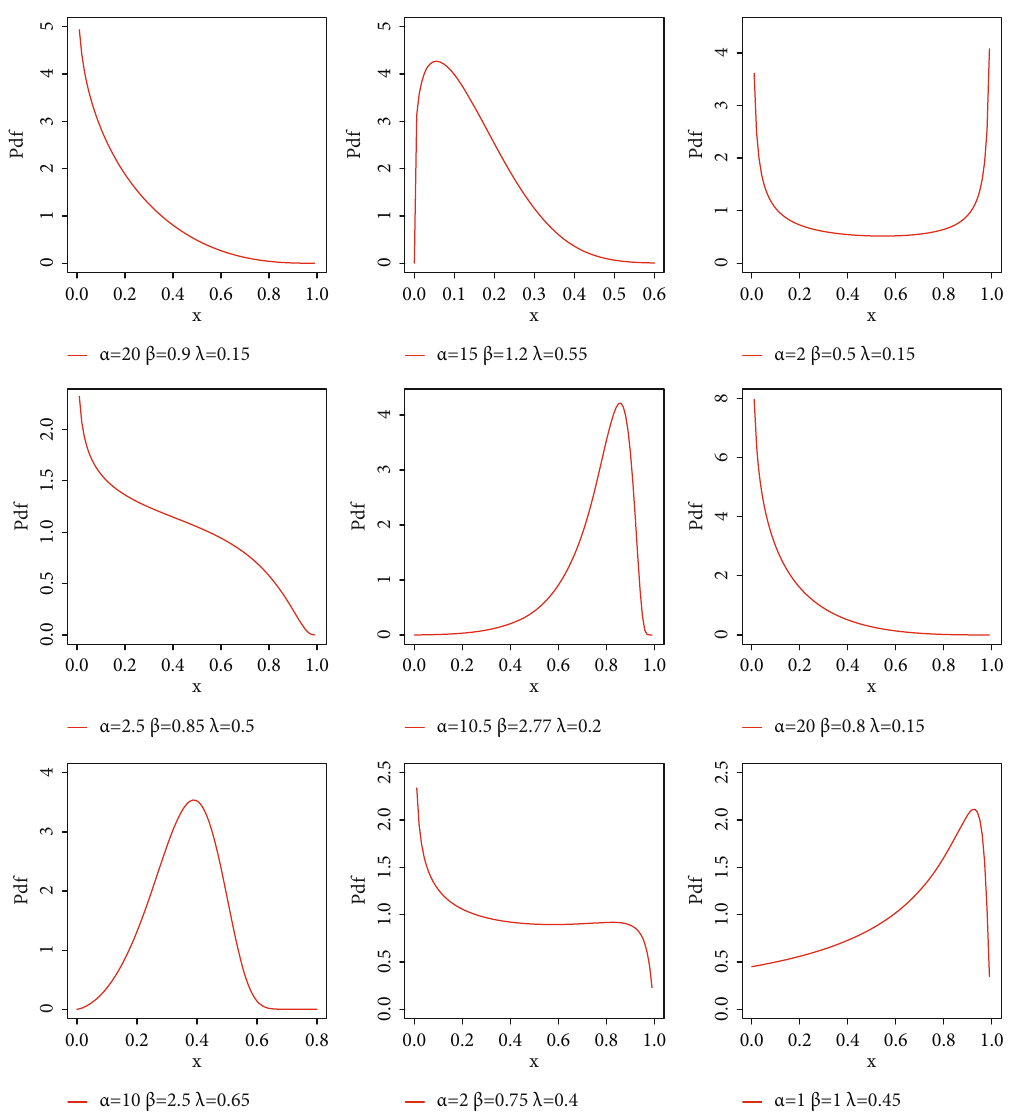
Figure 2: Plots of UPWD density for some parametric